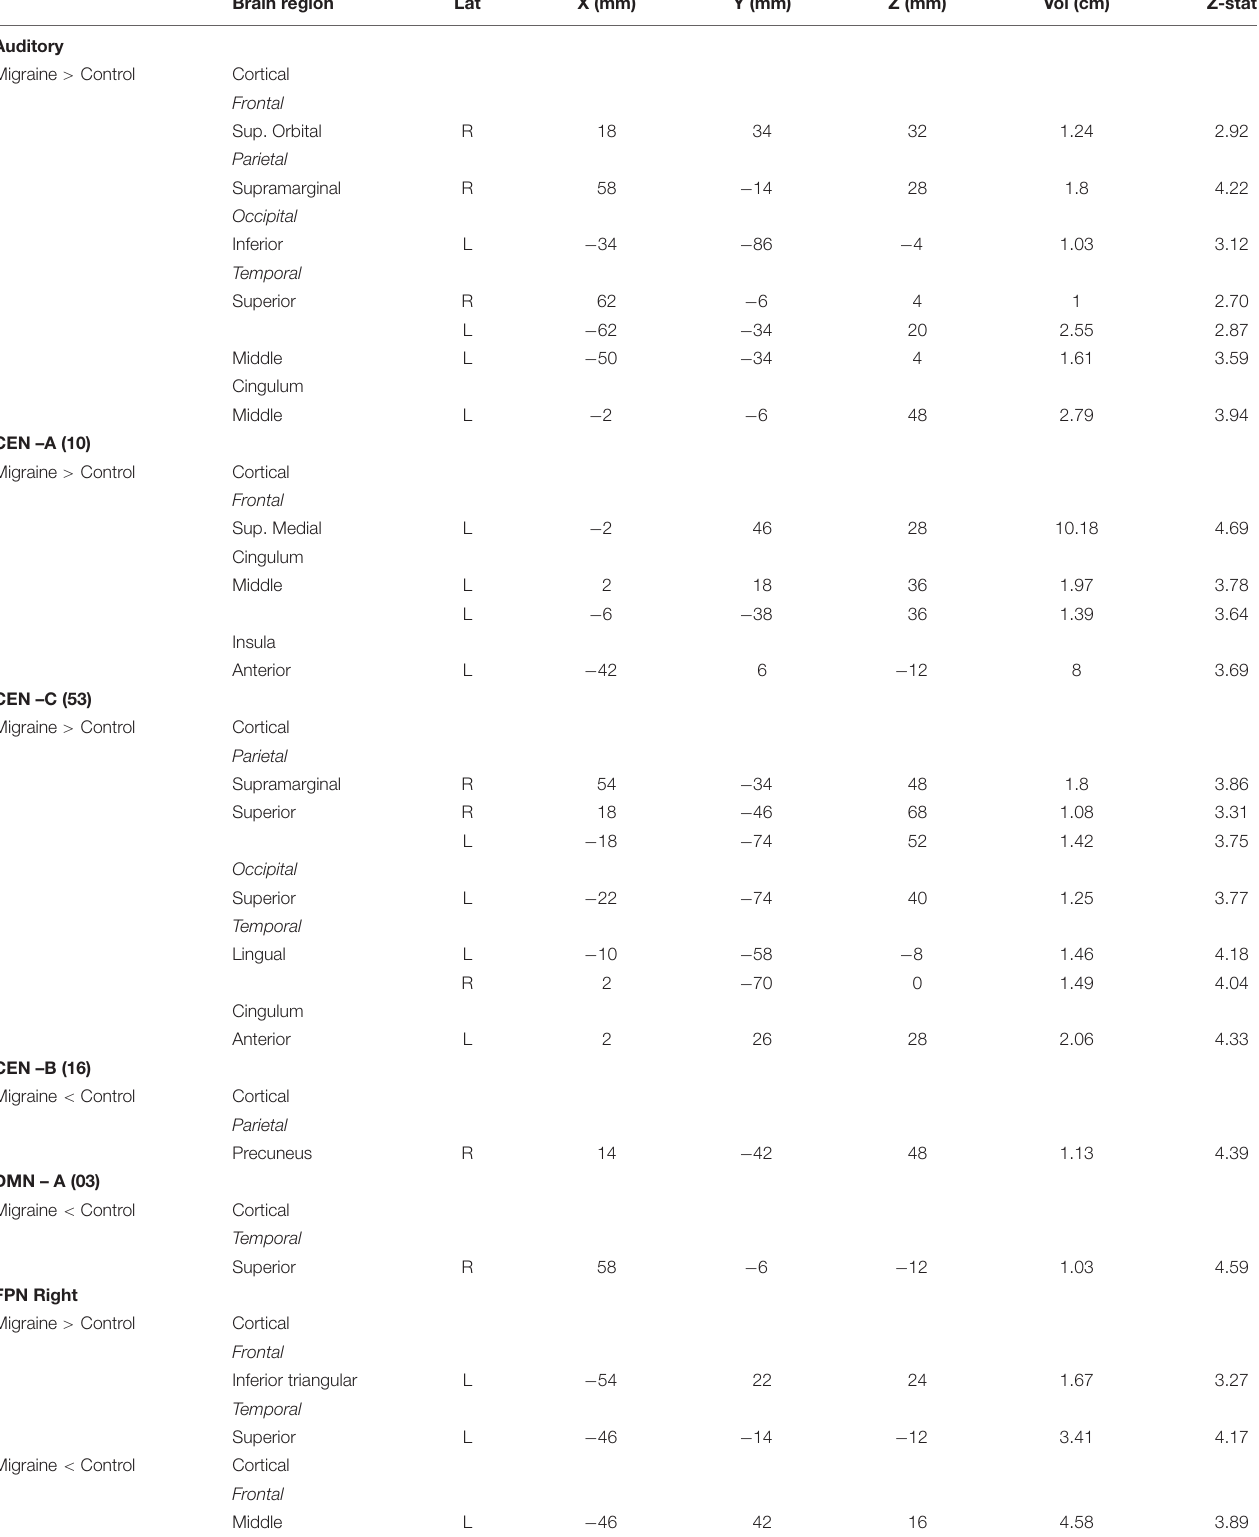
TABLE 4 | Disease effects in